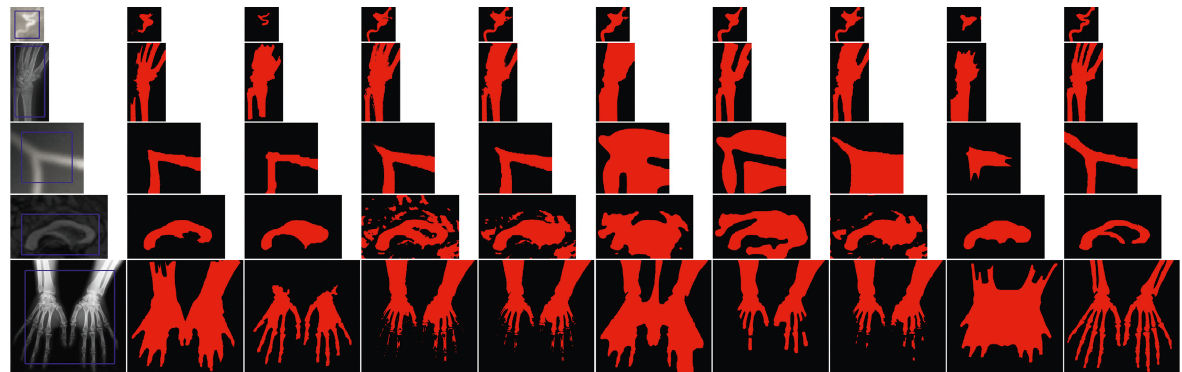
Figure 5: Comparison experiments on a group of medical images with different methods. The first column: input image along with initial contours; the second column: segmentation results of GAC model; the third column: segmentation results of LSR model; the fourth column: segmentation results of CV model; the fifth column: segmentation results of FTC model; the sixth column: segmentation results of LBF model; the seventh column: segmentation results of LAC model; the eighth column: segmentation results of LPFE model; the ninth column: segmentation results of NFT model; the tenth column: segmentation results of our model.